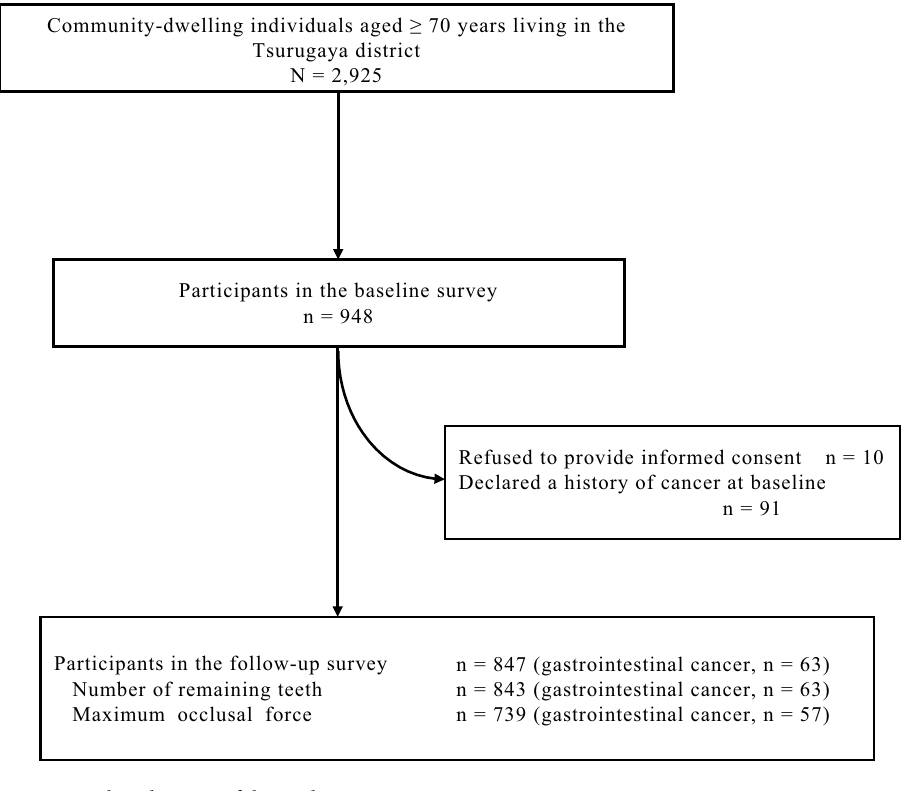
Figure 3. Flow diagram of the study